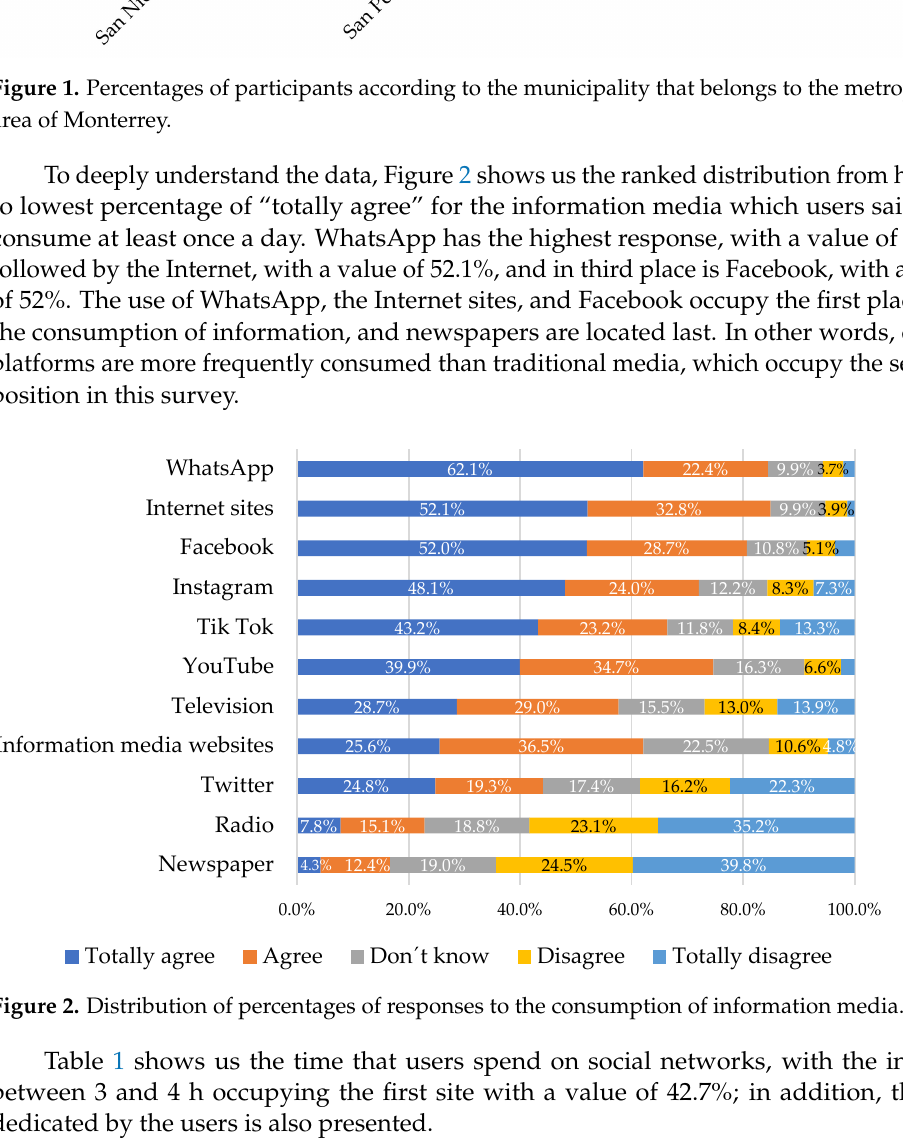
Table 1. Percentages of time intervals of use in social networks and the Internet. 273